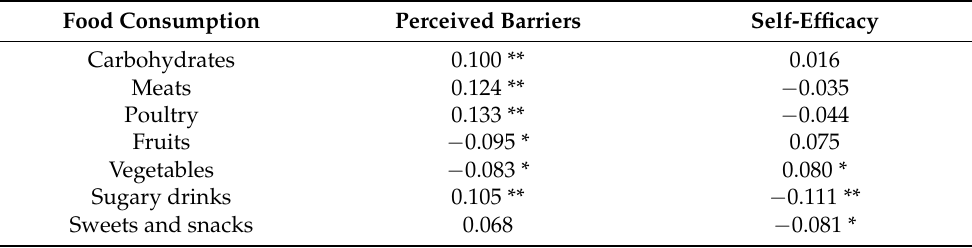
Table 4. Correlations between food consumption, perceived barriers, and